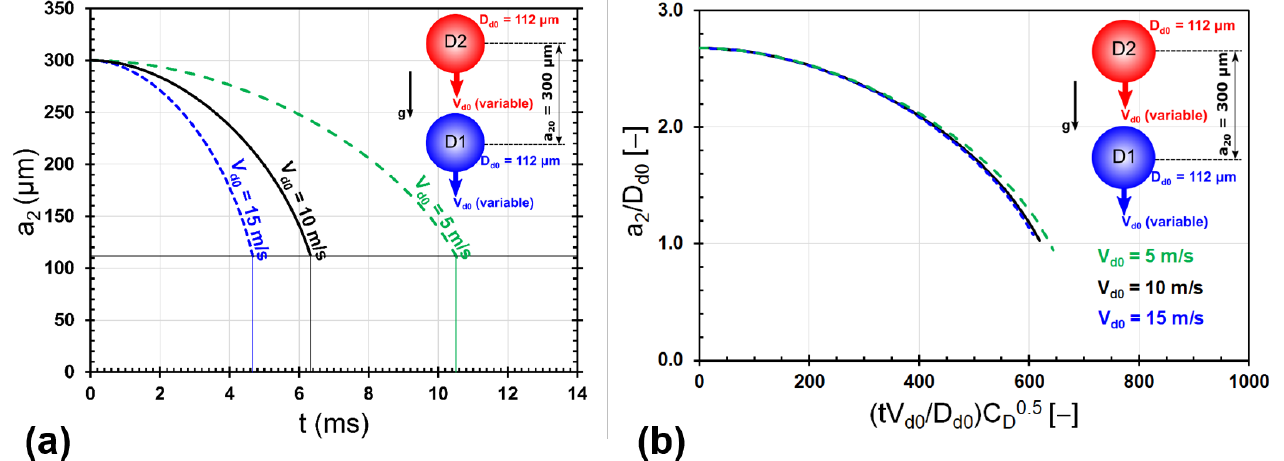
Figure 9. Effect of V d 0 on a 2 ( t ) : ( a ) Time evolution of the center-to-center separation of iso-propanol droplets in the double-droplet system for three typical cases of initial droplet velocities, V d 0 = 15, 10, and 5 m/s, as predicted by Equations (11)–(13). Other parameters are kept the same as in Figure 4: D d 0 = 112 µ m; a 20 = 300 µ m; C D is calculated using Equation (10). ( b ) Non-dimensionalized version of the plot shown in ( a ) using the non-dimensionalization discussed in Appendix